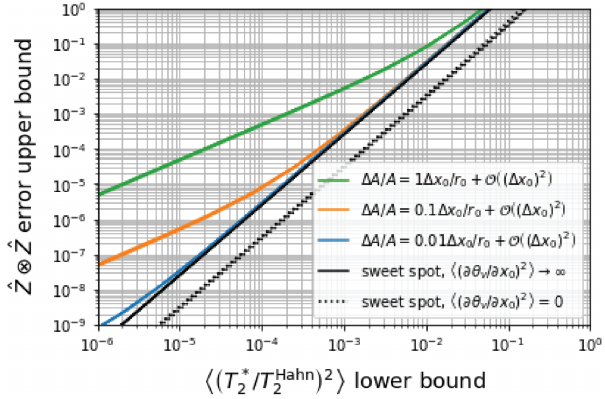
FIG. 5. The upper bound of the ˆ Z ⊗ ˆ Z error probability versus the lower bound of under various conditions, using the wave-function model of Eq. (5) and assumptions described in Sec. III B. The results are essentially identical for 500-ppm and 1000-ppm 29 Si and all four combinations of r 0 ∈ { 10 nm, 20 nm } and z 0 ∈ { 5 nm, 10 nm } . Results are shown both at and away from the sweet spot. The solid (dotted) black curves are at a sweet spot in the pessimistic (optimistic) limit with respect to valley- phase contributions. The colored curves are away from the sweet spot, with three different first-order contributions to (cid:14) A / A [for context, see Eq. (7)].